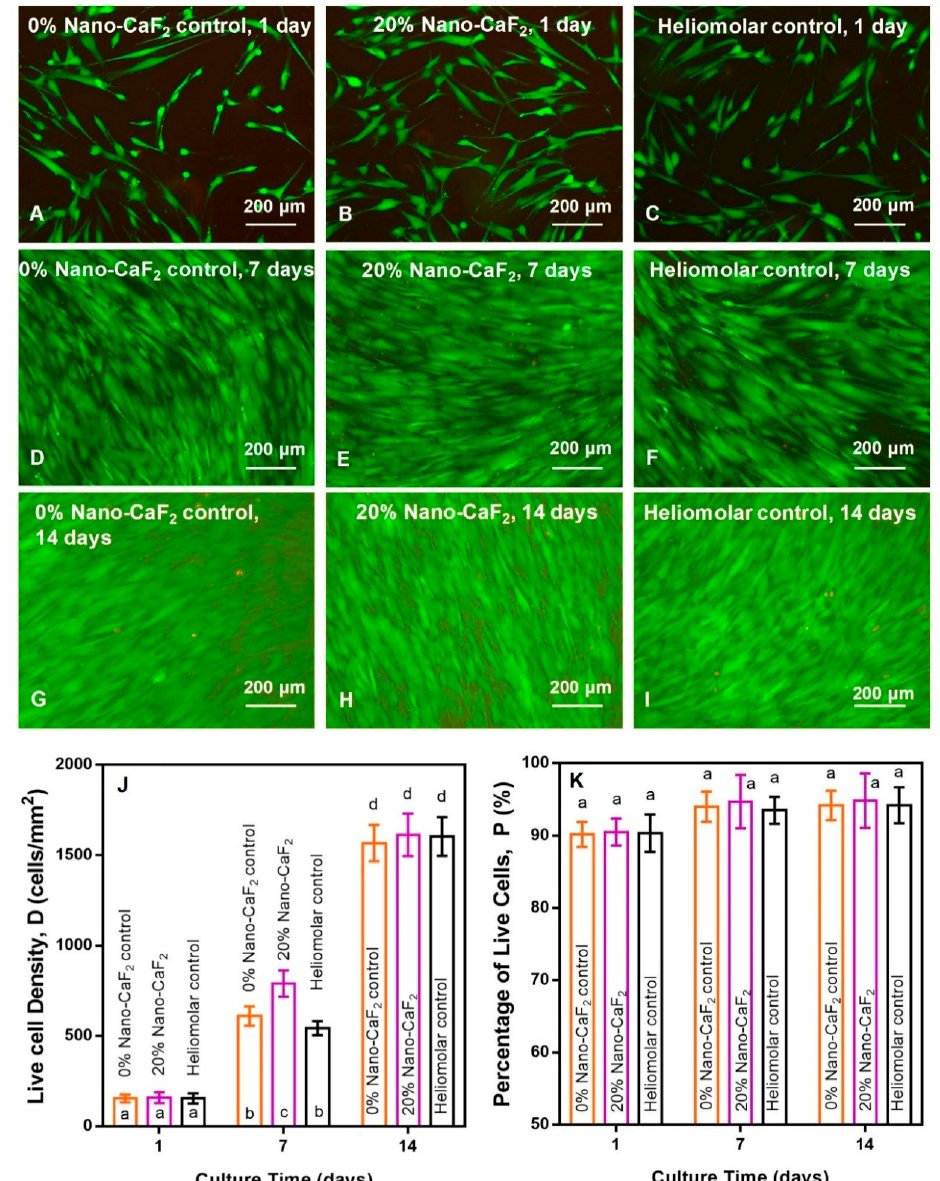
Figure 4. ( A – I ) The live/dead staining of hPDLSCs on omposites. Live cells (green) were numerous and dead cells were very few (n = 6). ( J ) The live cell density (the number of live cells per area) for 20% Nano-CaF 2 composite was slightly higher than 0% Nano-CaF 2 and Heliomolar control (by approximately 1.3 folds and 1.5 folds at 7 days) Values with dissimilar letters such as a and b are significantly different ( p < 0.05). ( K ) The percentage of live cells was nearly constant in all three groups ( p > 0.1, mean ± SD; n = 6).